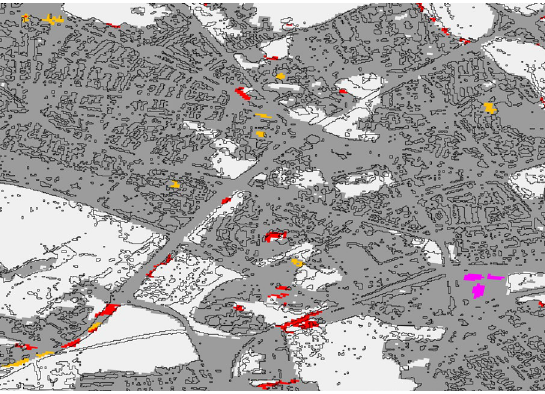
Fig. 8. Comparison of SENTINEL -2 NDVI products with Copernicus